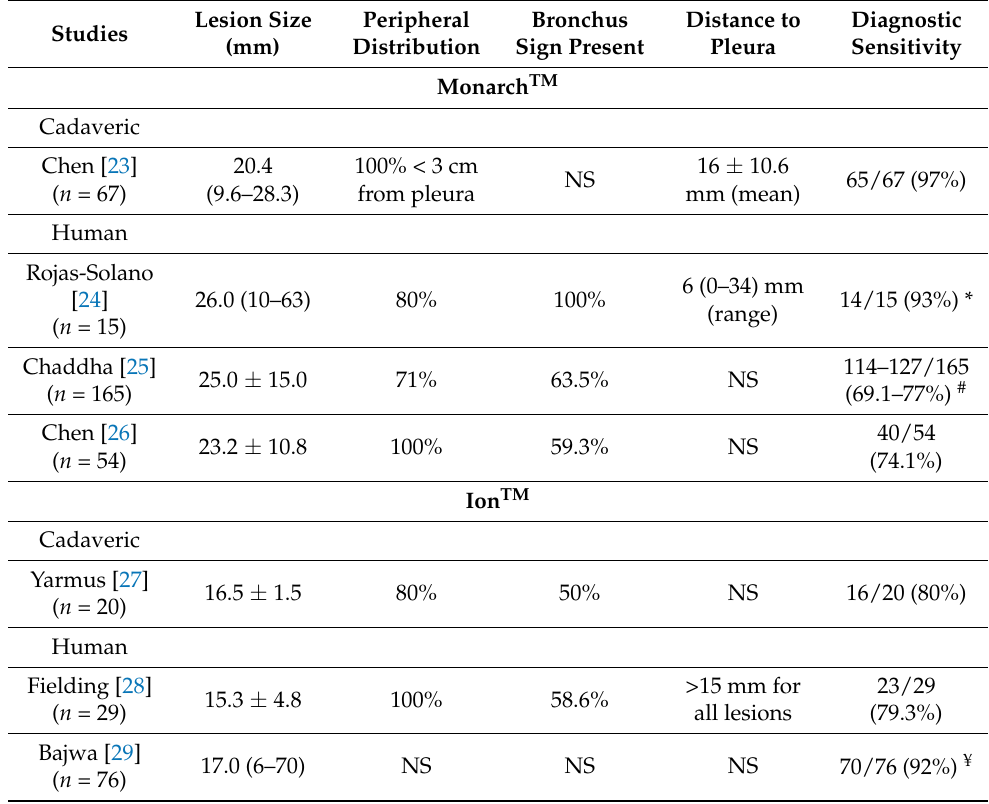
Table 2. Comparative summary of evidence for both robotic